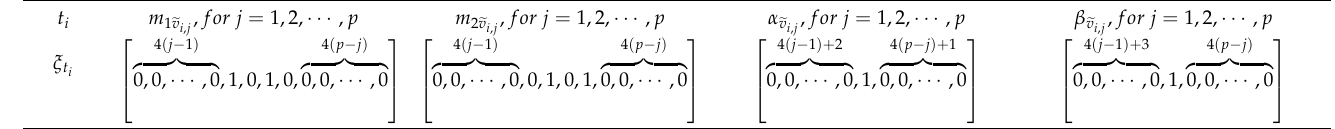
Table 3. ξ for VFCSS applying over LR-type fuzzy numbers when metric (13) is